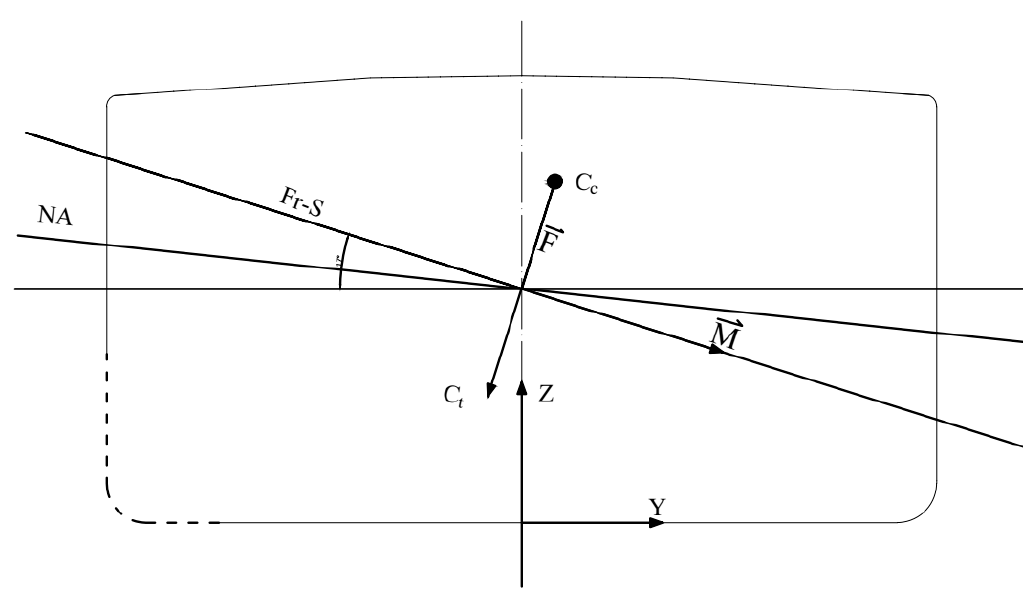
Figure 2. Force acting on asymmetric cross-section, where the dashed line denotes the damage.